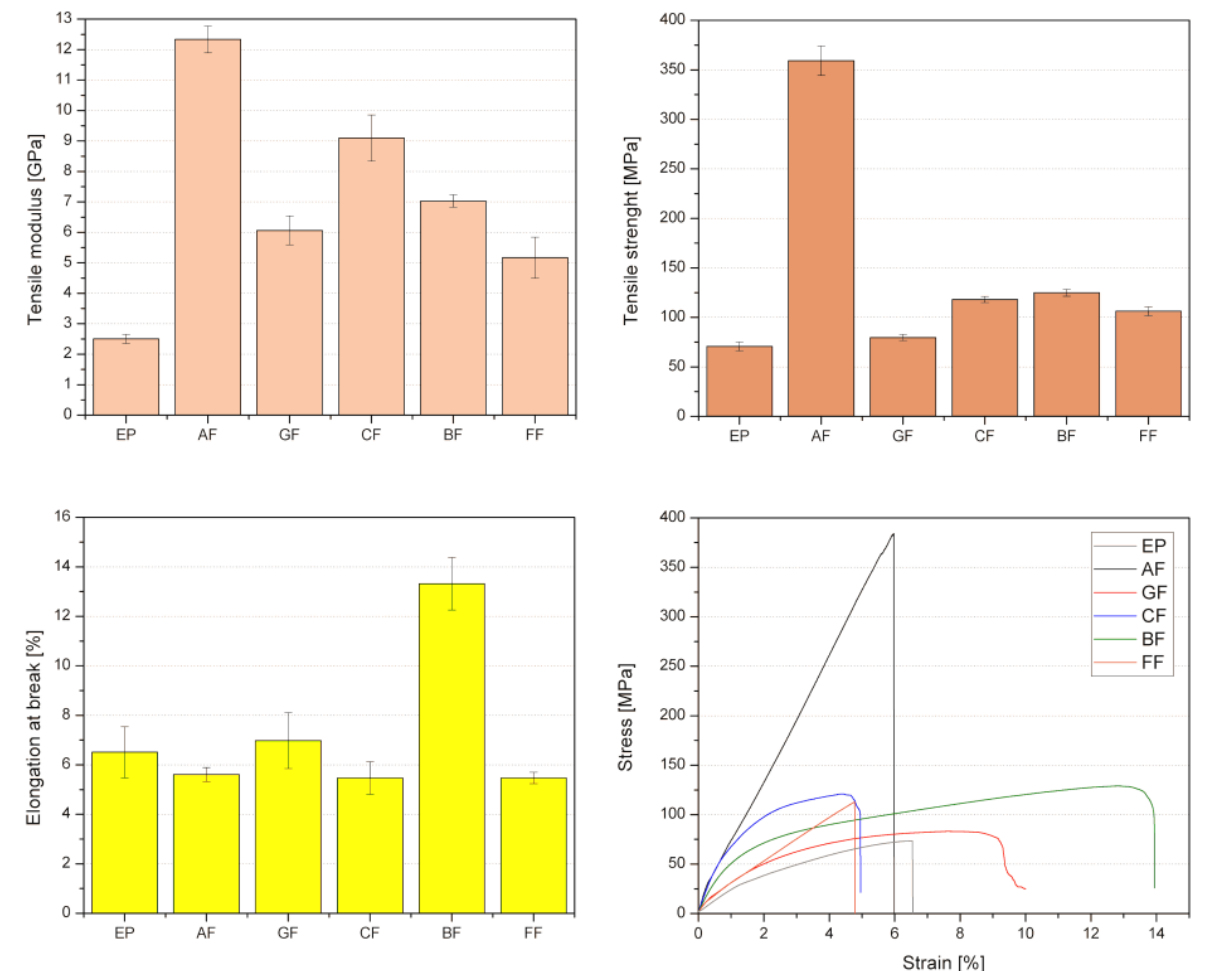
Figure 7. Mechanical properties of EP and EP-composites obtained from tensile test.